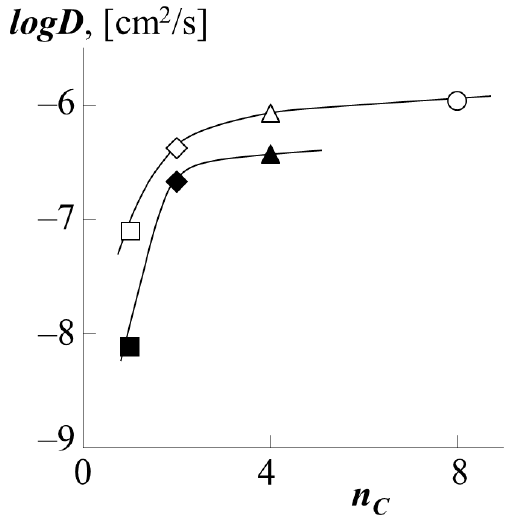
Figure 11. Dependence of the partial diffusion coefficients of PS-1 (white dots) or PS-2 (black dots) into the matrix of PBA (triangle), PEA (rhombus), PMA (square) or PEHA (circle) on the number of carbon atoms in the side chains polyacrylate.